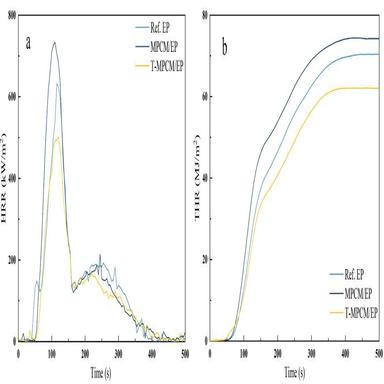
Curves HRR a and THR b of Ref. EP and EP composites containing different MPCM samples.